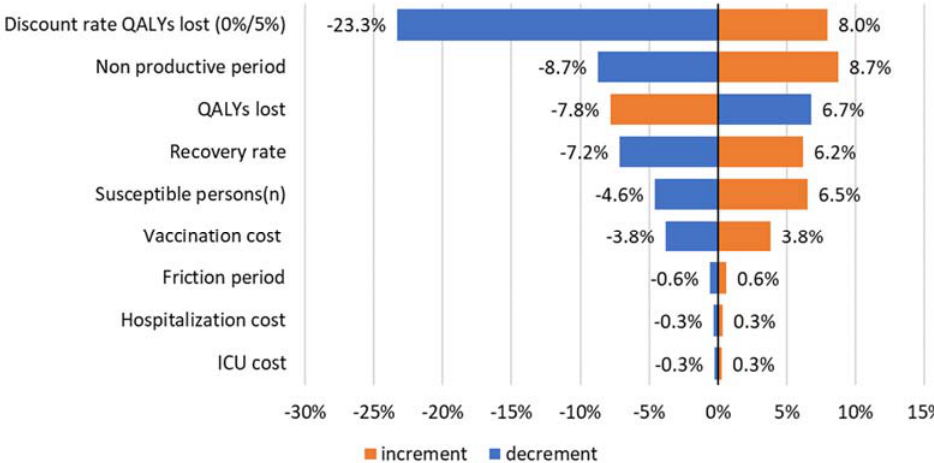
Figure 8. ICER sensitivity analysis (+/ − 10%; except for discount rate QALYs lost at 0% and 5%) for a limited transmission effectiveness.